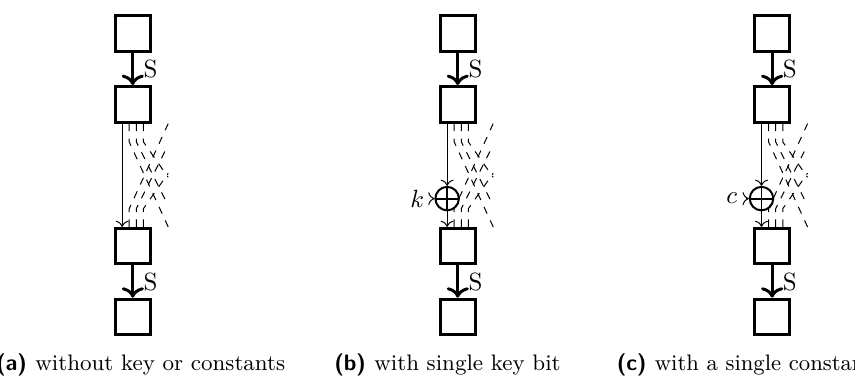
Figure 8: The three types of permutation in GIFT round